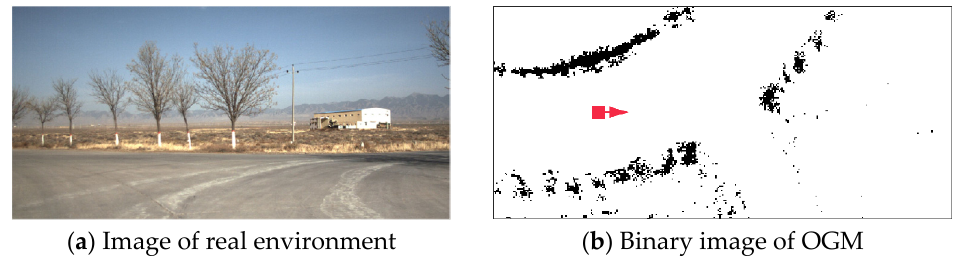
Figure 5. A binary image corresponding to a real environment.